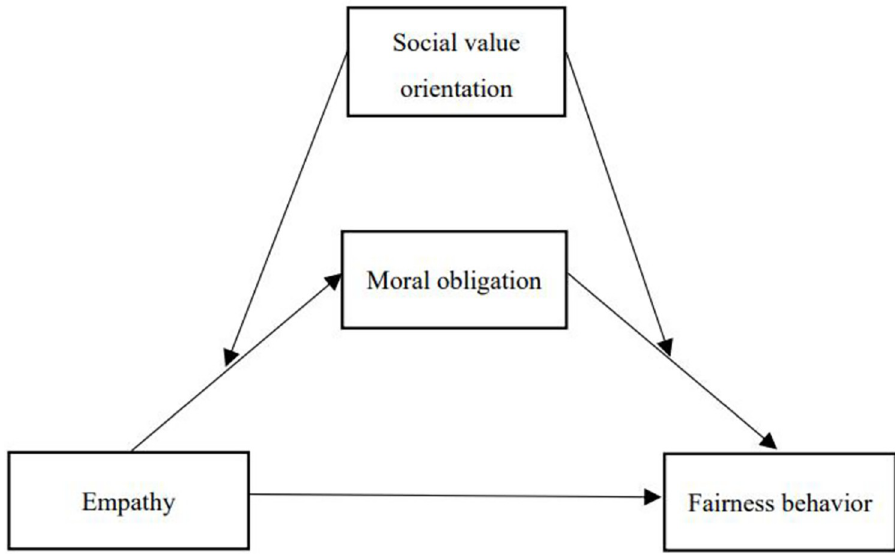
Fig 1. Proposed moderated mediation